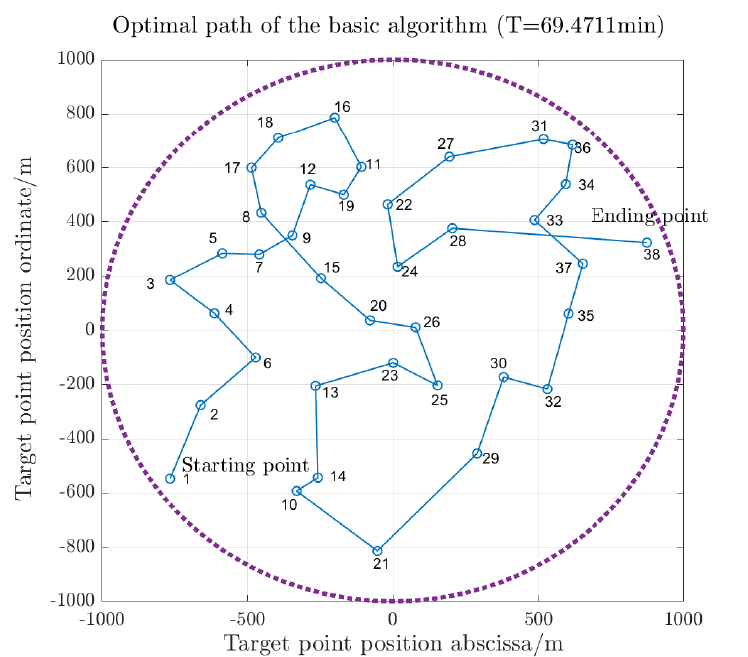
Figure 6. Optimal path created by the basic algorithm.